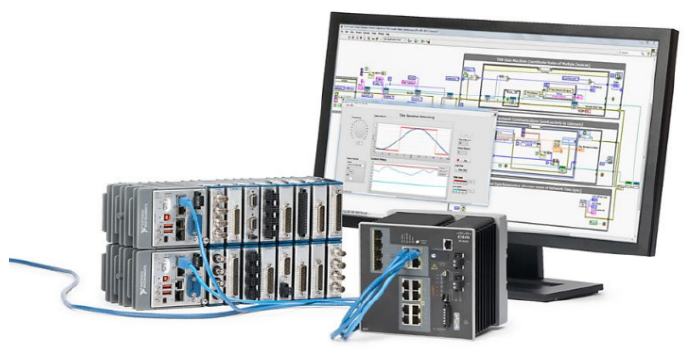
Figure 1. National Instruments hardware and software platform [35].